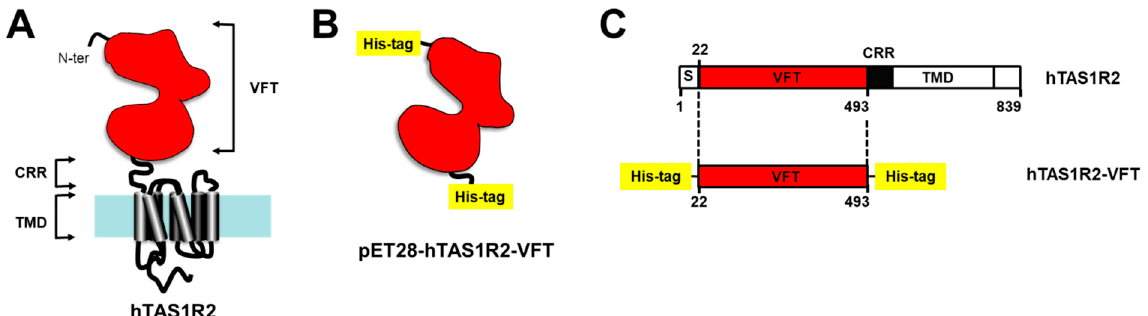
Figure 1. Strategy used for the expression of hTAS1R2-VFT in bacteria. ( A ) The Venus Fly Trap domain (VFT) of human TAS1R2 was expressed independently from the transmembrane domain (TMD), minus a short putative signal peptide (S) and a cysteine-rich region (CRR). ( B ) The pET28- hTAS1R2-VFT vector encodes a fusion protein that contains an N-terminal His-tag cleavable with thrombin, followed by hTAS1R2-VFT (Ala22-Ser493) and a C-terminal His-tag. ( C ) Full-length hTAS1R2 is represented according to its primary amino acid sequence deduced from the DNA sequence. The numerical positions of amino acid residues of hTAS1R2 are indicated.